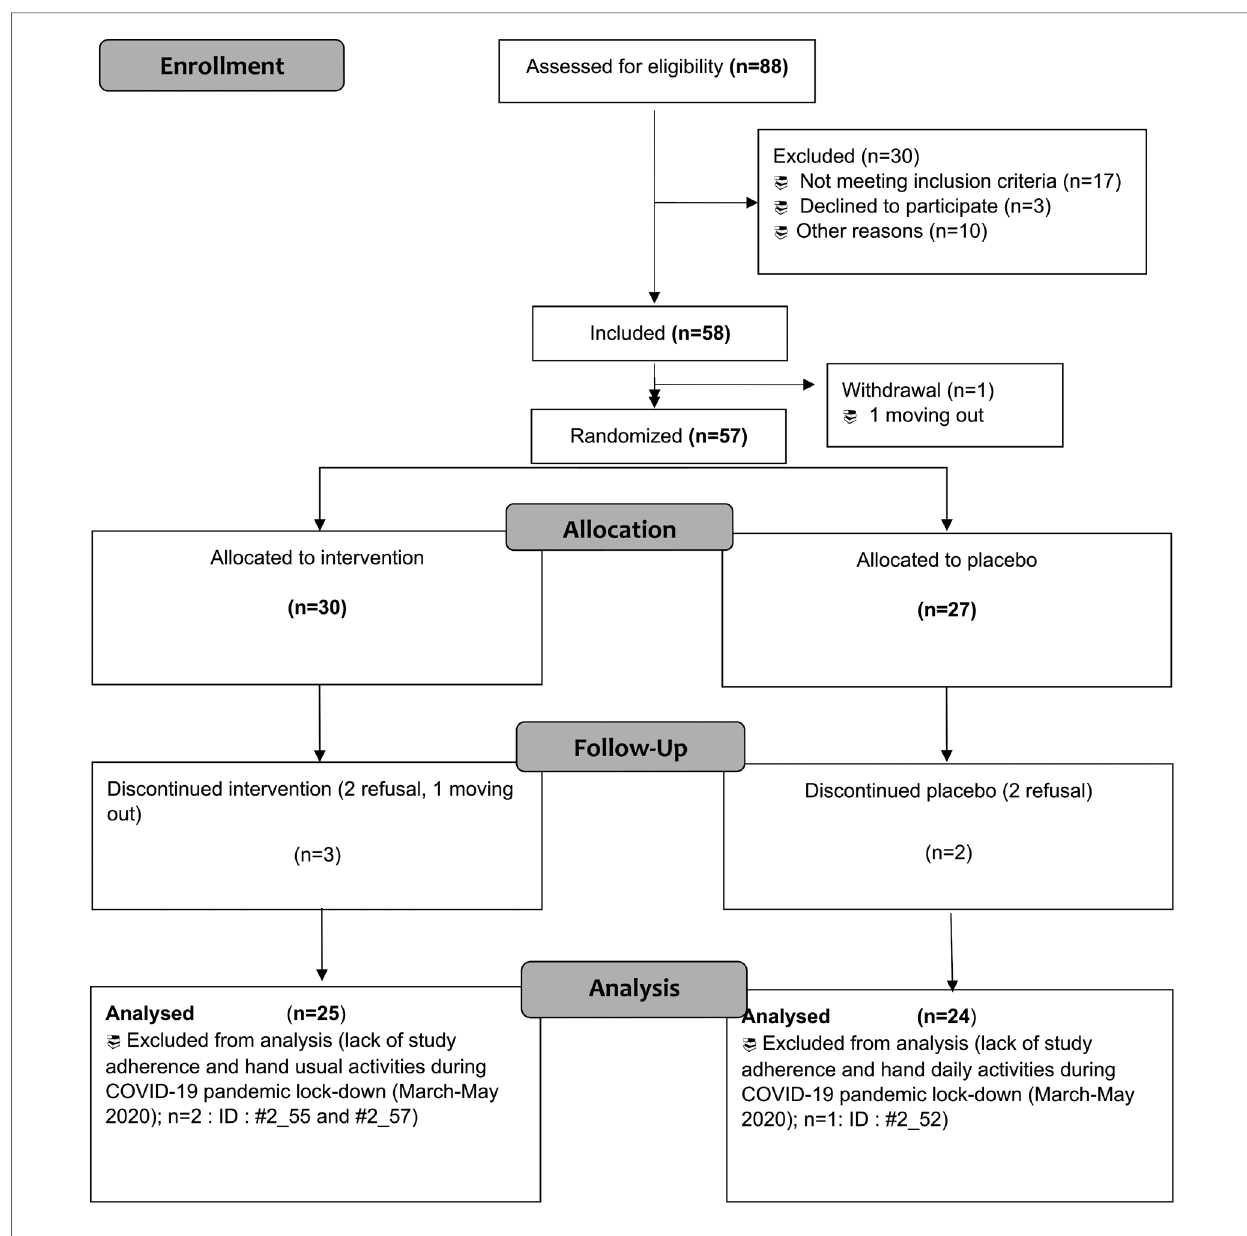
FIGURE 1 CONSORT fl ow